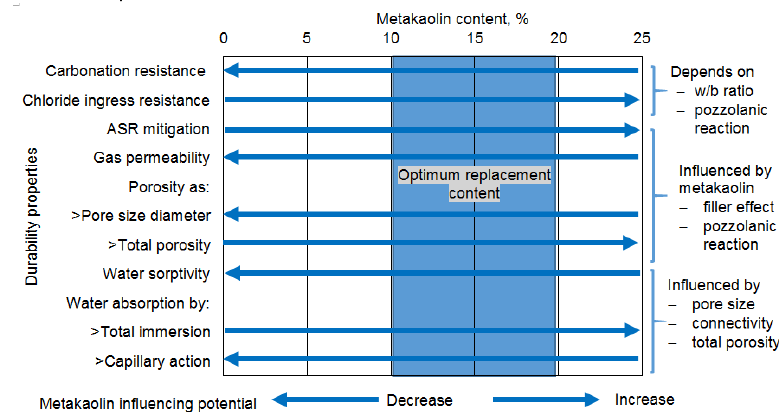
Figure 2. Schematic diagram showing the influence of metakaolin on concrete durability